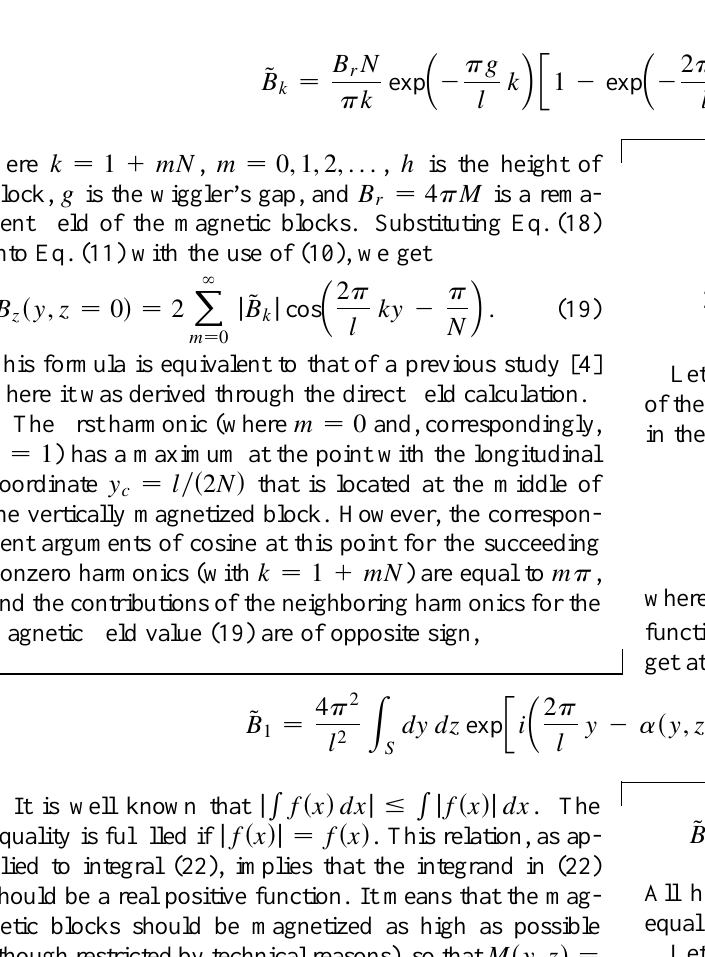
FIG. 1. Halbach wiggler configuration.